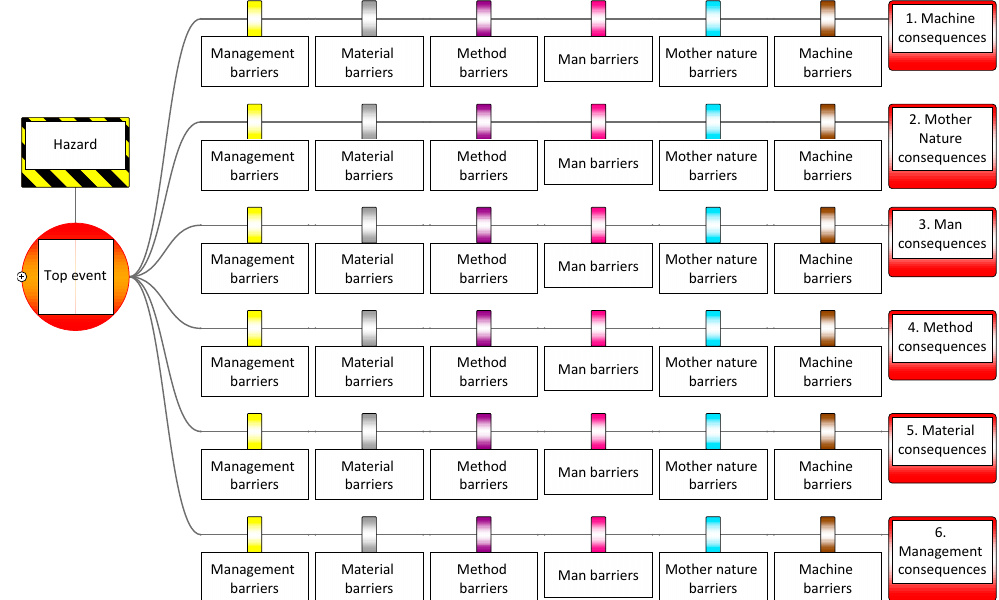
Figure 12. Consequence side of the Bowtie diagram with 6M mitigation barrier structure